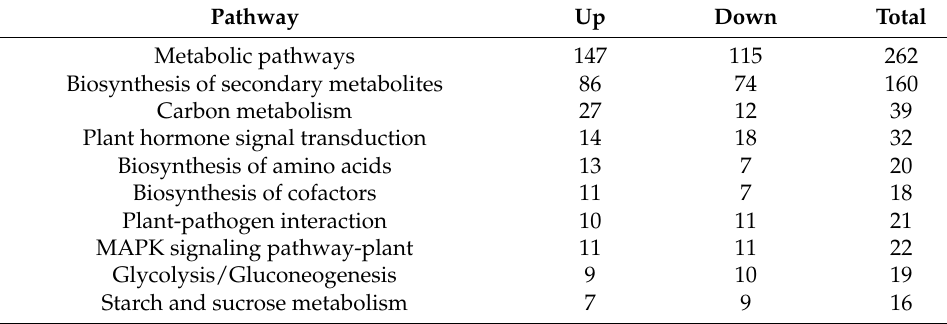
Table 7. Top 10 pathways enriched in the “H 2 O7d + FOL1h vs. MgO7d + FOL1h” group. Pathway Up Down Total Metabolic